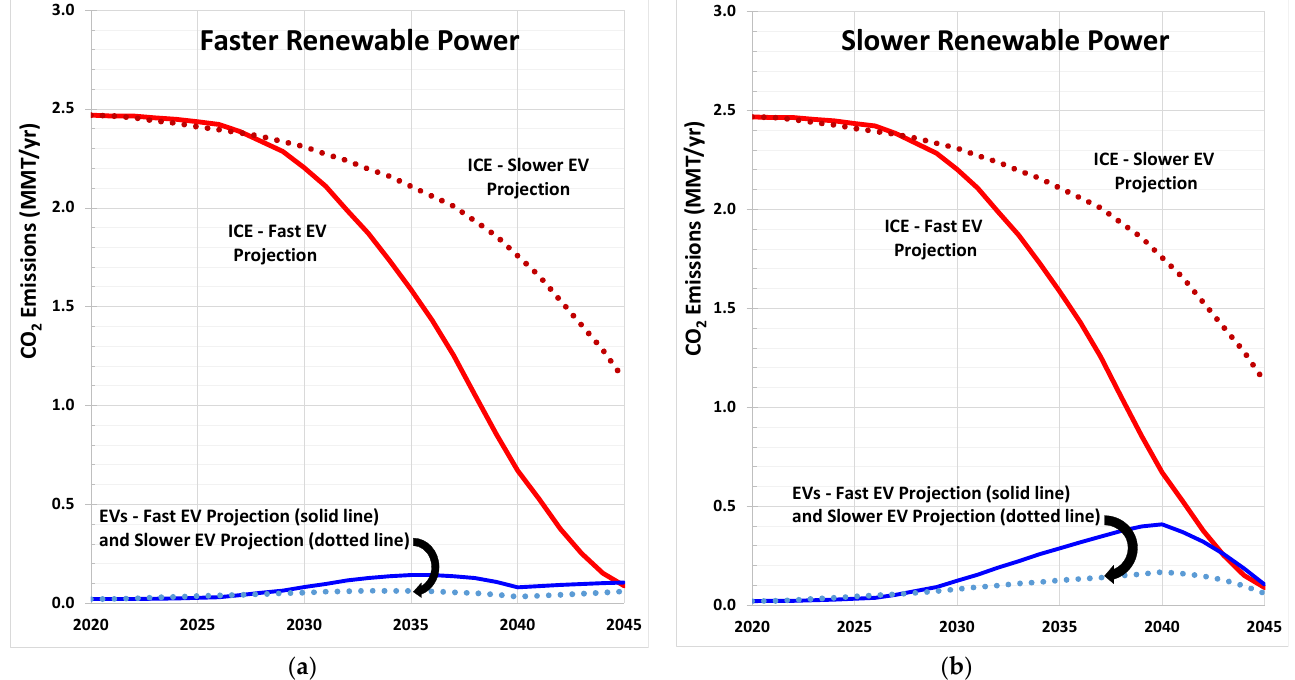
Figure 16. Total passenger vehicle CO 2 emissions showing the impact of the faster EV projection (solid lines), and slower EV projection (dotted lines): ( a ) Faster renewable power projection; ( b ) Slower renewable power projection.